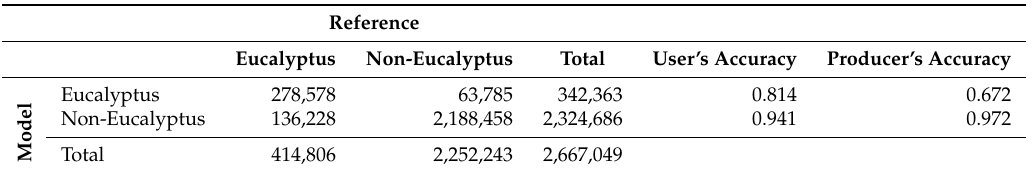
Table 2. Confusion Matrix for the model output at a threshold of 0.53 for all three validation regions